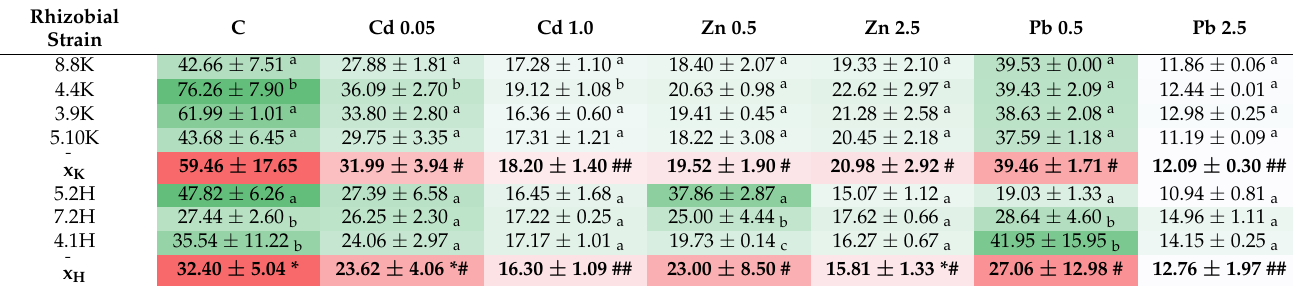
Table 2. Thickness of biofilms ( µ m) formed by R. leguminosarum bv. trifolii strains isolated from root nodules of T. repens growing on non-polluted reference grassland Bolestraszyce (K) and 100-year-old Zn–Pb waste heap Bolesław (H) not exposed (C) and exposed to 0.05 mM Cd (Cd 0.05) and 1.0 mM (Cd 1.0), 0.5 mM Zn (Zn 0.5) and 2.5 mM Zn (Zn 2.5), and